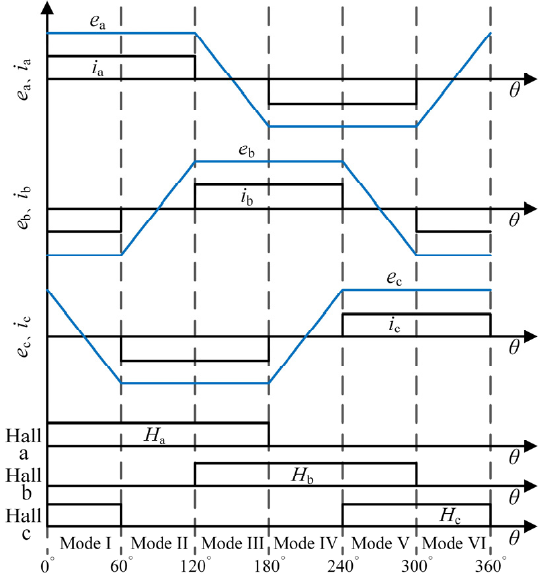
Figure 2. Schematic diagram of back EMF, phase current, and Hall signal of BLDCM.